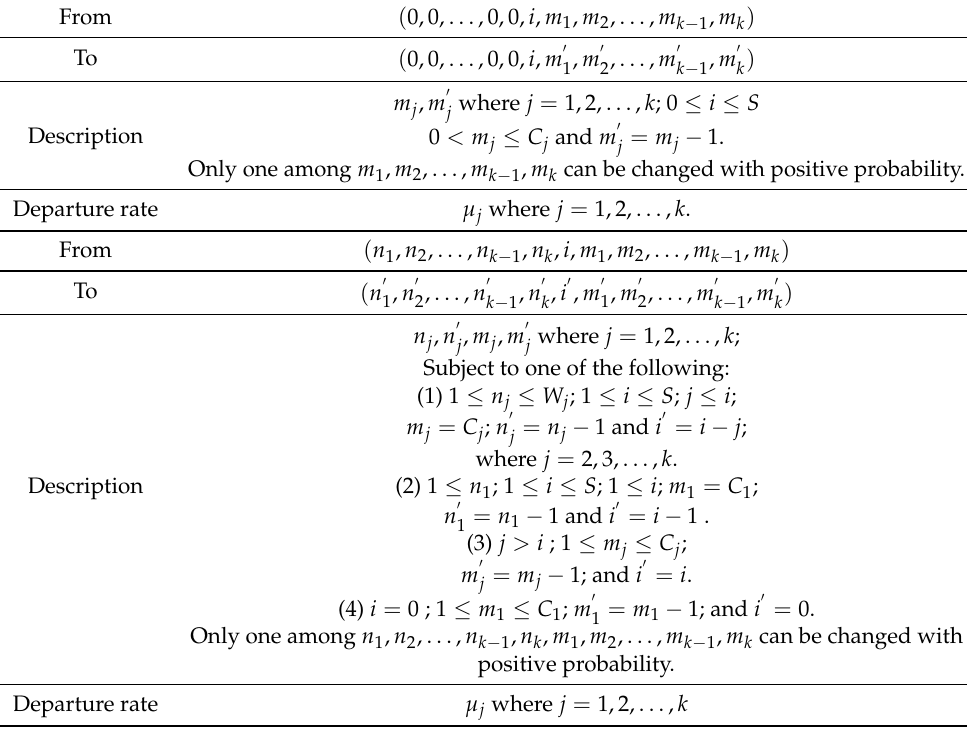
Table 2. Departure rates.